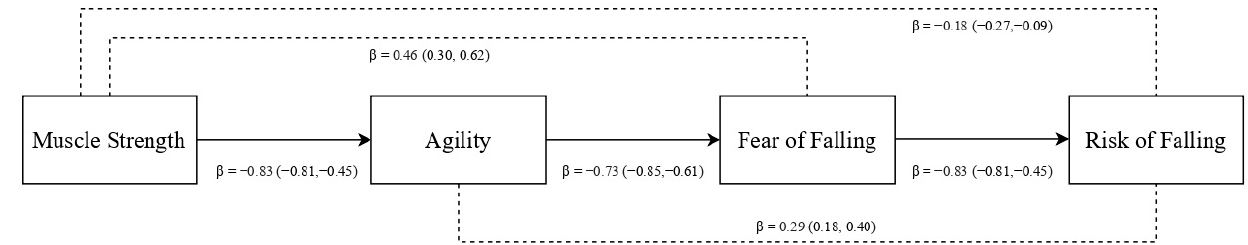
Figure 1. Path model. Notes: Standardized coefficients are reported; within brackets = 95% confidence interval; straight lines = direct effects; doted lines = indirect effects.